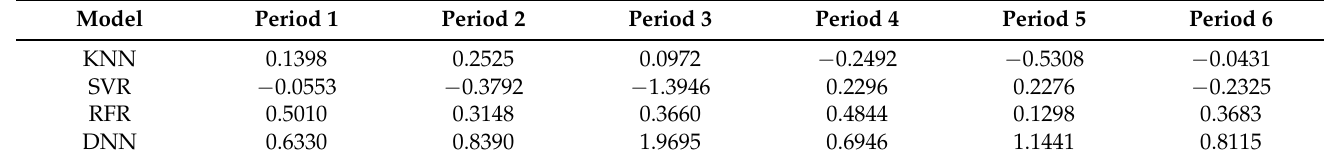
Table 2. Distribution of regression coefficients within the second level model (MLR).